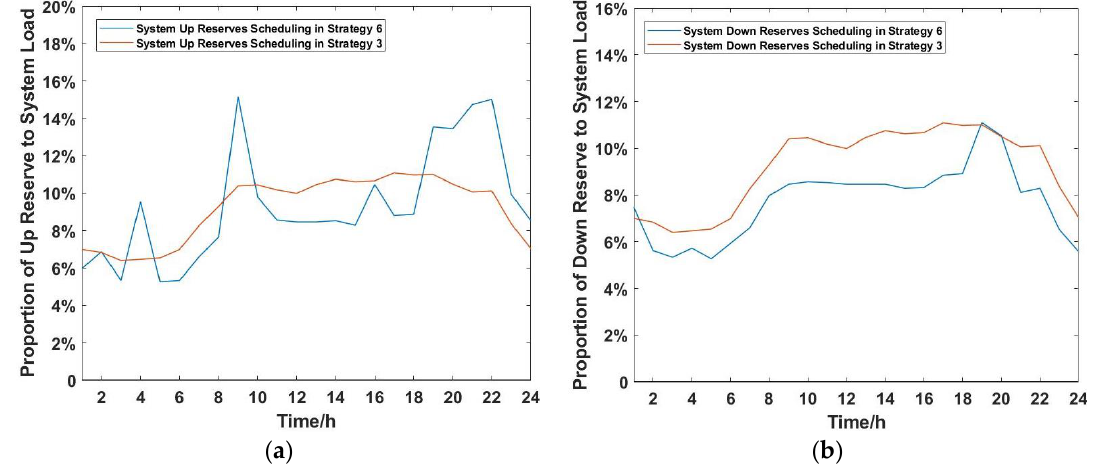
Figure 9. CSP and system reserve planning results at stochastic scenario 3, including: ( a ) the total scheduled system up reserves in Strategy 3 and Strategy 6; ( b ) the total scheduled system down reserves in Strategy 3 and Strategy 6.